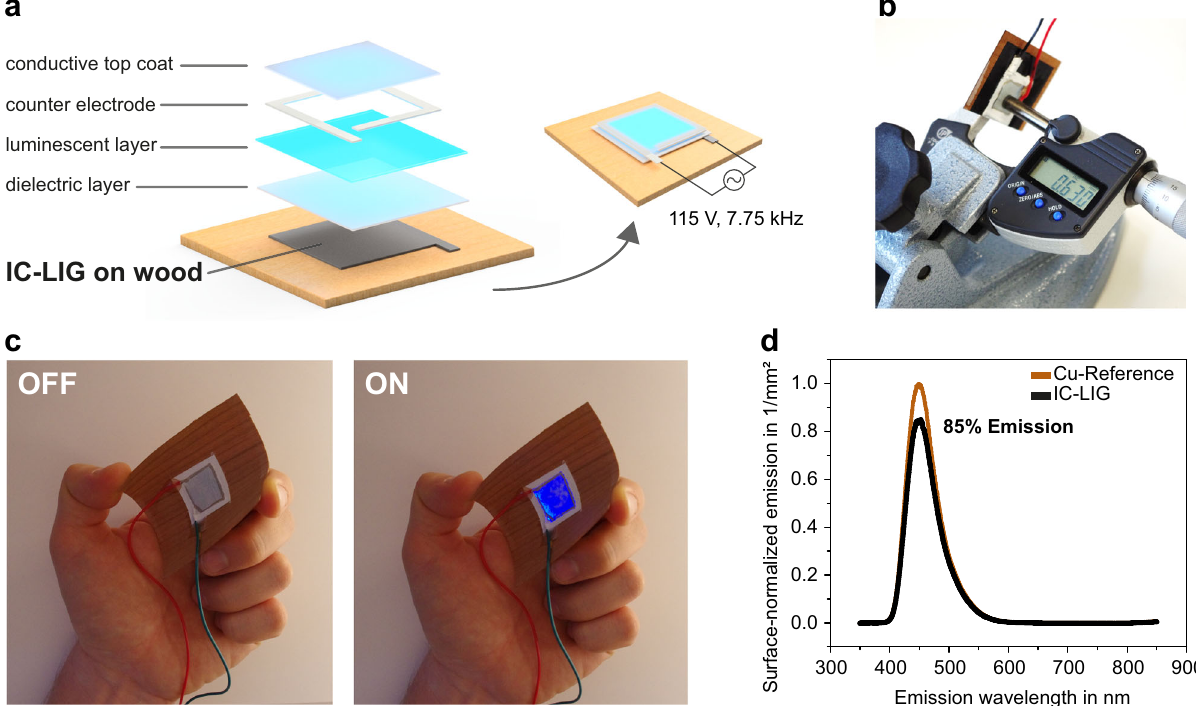
Fig. 6 IC-LIG-Wood electroluminescent (EL) device. a Exploded view and schematic representation of our IC-LIG-wood EL device. b The whole EL device is only 630 µ m-thick. c Showcasing the operation and fl exibility of our IC-LIG-wood EL device. d Comparison of light emission ef fi ciency between our EL device, made with an IC-LIG back electrode, and a reference device made with copper-foil as back